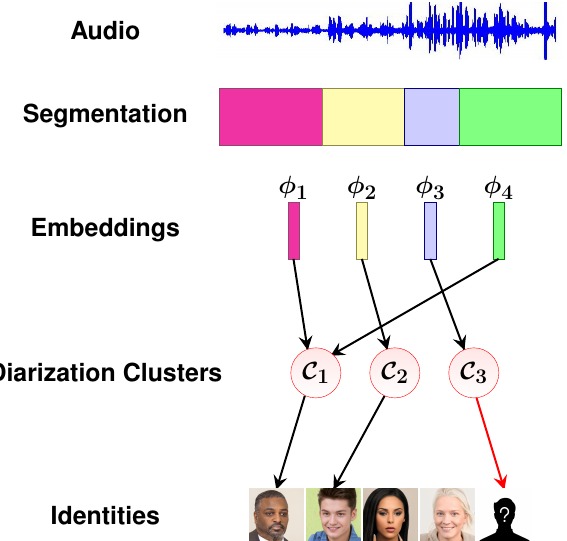
Figure 5. Diagram of the indirect assignment approach. Embeddings from the audio are first clustered during diarization ( ,..., ). Then, clusters are assigned to the available identities, either C 1 C 3 the enrolled speakers or the unknown generic cluster (red